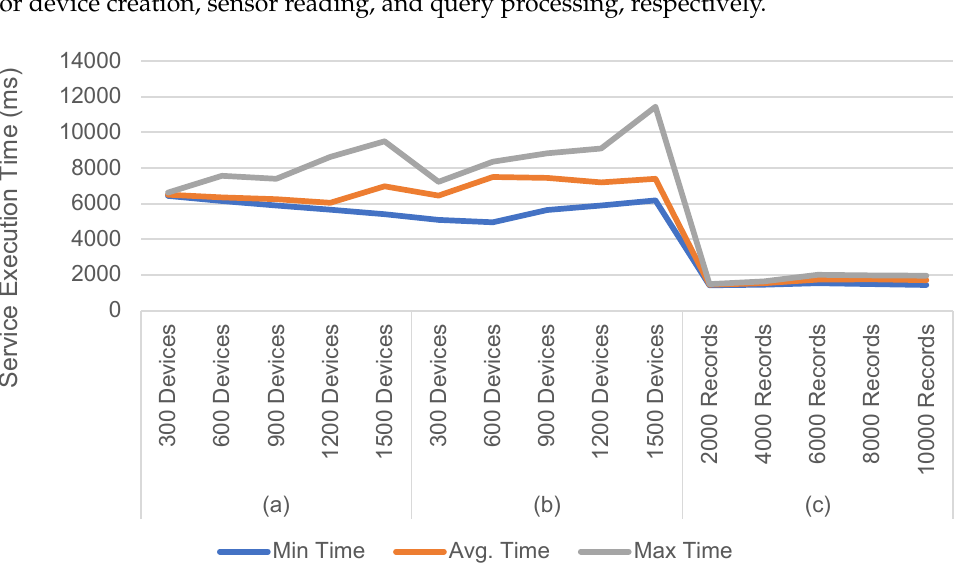
Figure 11. Collaborative performance evaluation: ( a ) performance evaluation for device creation; ( b ) performance evaluation for sensor reading; ( c ) performance evaluation for query processing.